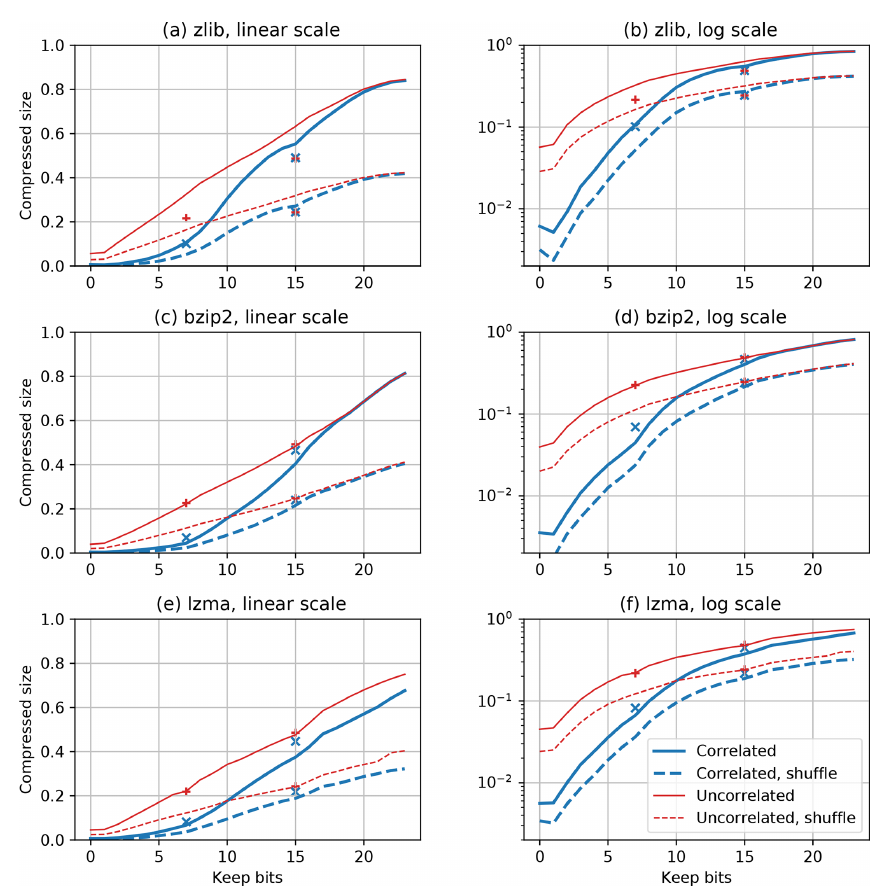
Figure 5. The normalized compressed size (compression ratios) of the arrays shown in Fig. 2, as a function of the number of keep bits for mantissa rounding with and without shuffling. Compression ratios for same arrays packed with linear packing are shown with points of respective color. The ratios are shown both in linear and logarithmic scale for three compression methods. Twenty-three keep bits correspond to the original